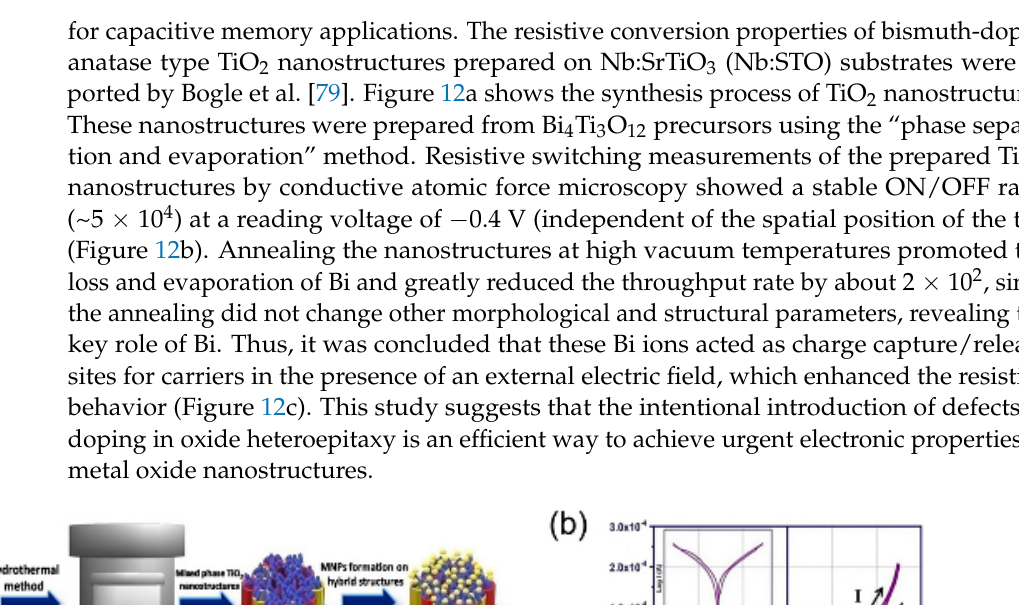
16 of 22 Figure 10. N-TiO 2 device instantaneous photocurrent response to UV light ( a ) with di ff erent Ee val- ues or ( b ) with di ff erent durations. ( c ) Schematic of a N-TiO 2 device. ( d ) Schematic diagram of hole storage in N-TiO 2 NC (green spheres) and schematic diagram of hole recombination in commercial